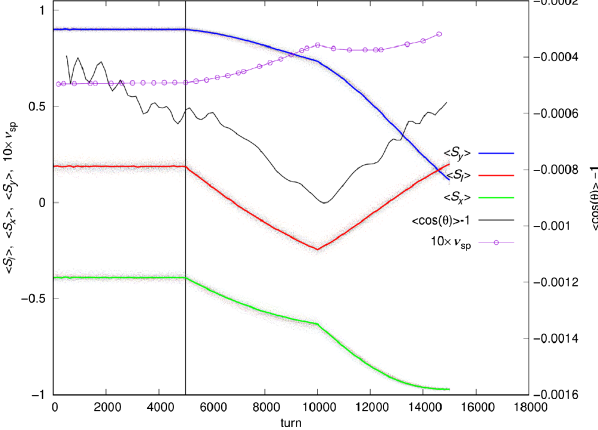
FIG. 36. Polarization rotation from vertical to radial over 10,000 turns observed at p-C polarimeter (current ramp starts at turn 5000, materialized by the vertical bar). Dots: spin components of a few individual particles; superimposed solid lines: turn-by-turn average of 1000 particle spin components. Black solid line (right axis): departure from 1 of the bunch ⃗ S h ⃗ S i , the projection of polarization ( i.e. , the average value of i · ⃗ S h ⃗ S i ). Empty circle markers individual spins i on their average (left axis): spin tune ν , times 10, from Fourier analysis. sp